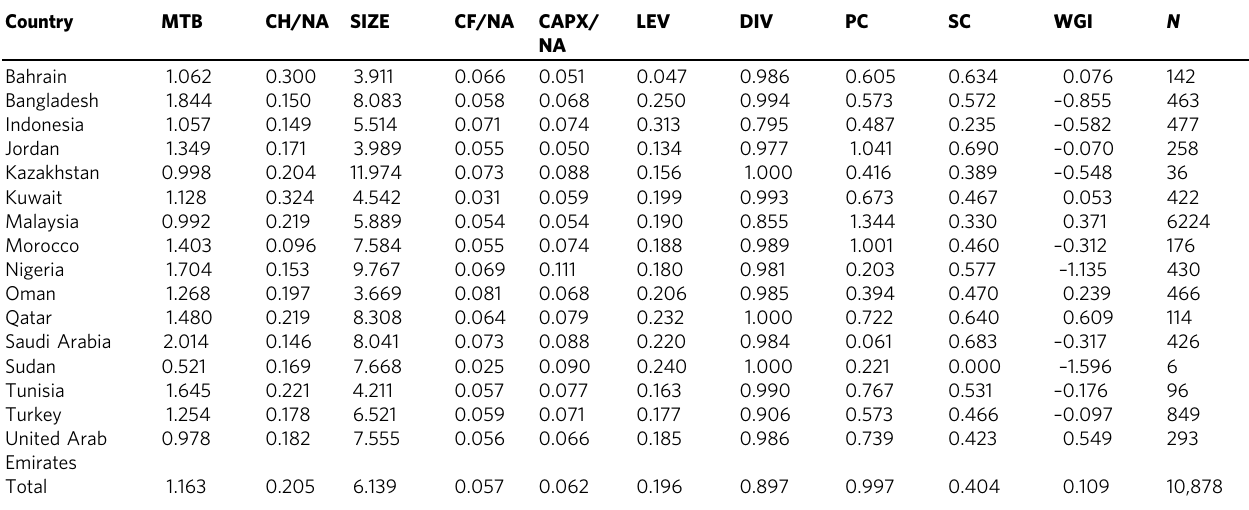
Table 1 Descriptive statistics based on full sample. Country